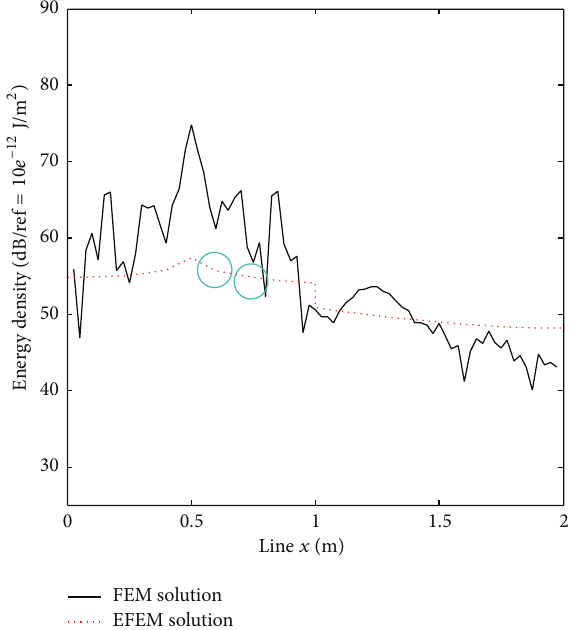
Figure 12: Comparison of the energy density along the dotted line between FEM solution and EFEM solution.